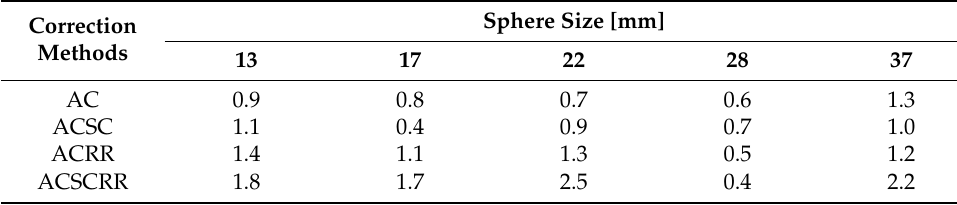
Table 3. Comparison of absolute error of the CNR between the SS and SSC modes.